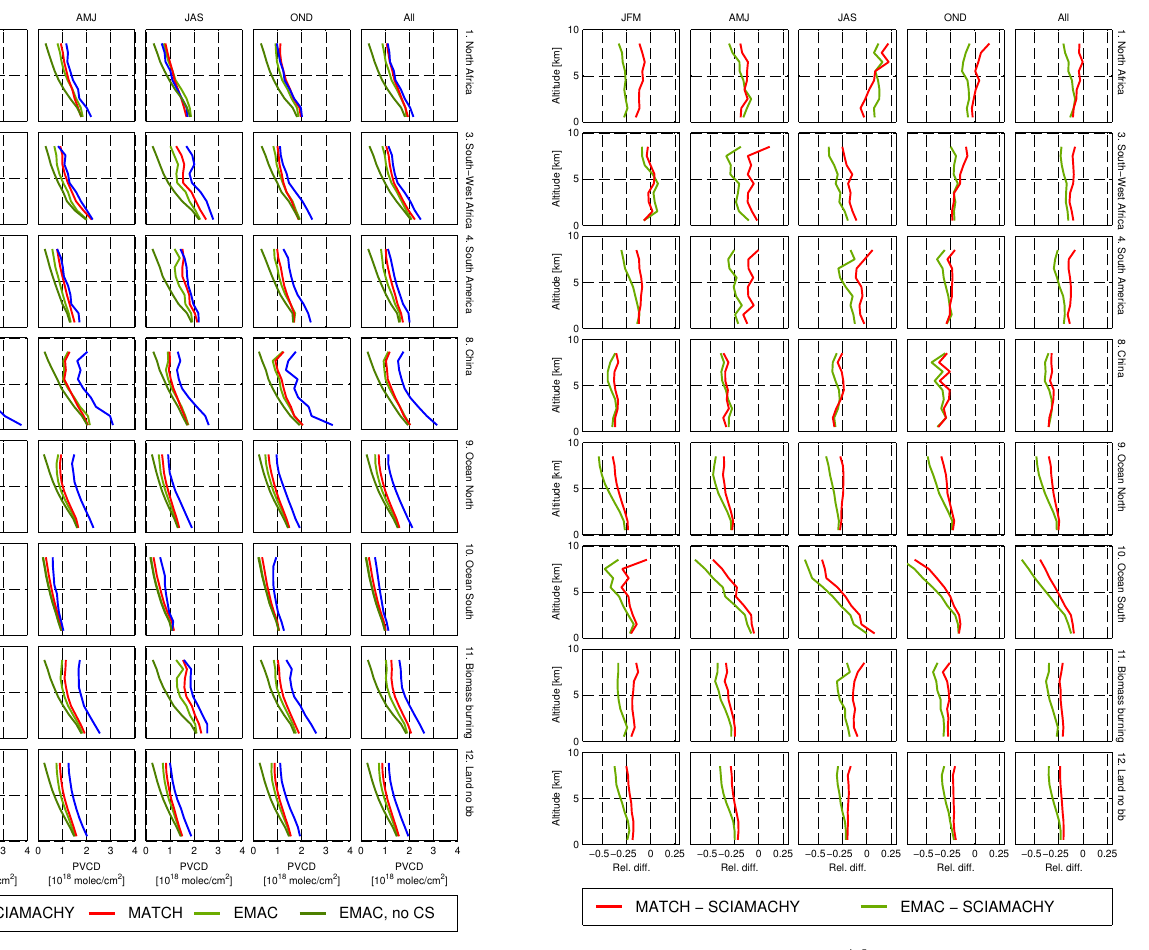
Fig. 9. Comparison of seasonally and annually averaged profiles of CO PVCDs from SCIAMACHY observations and model sim- ulations for selected regions (see Fig. 8). In addition to results for the selected regions, also average results for biomass burn- ing regions (second row from bottom) and for observations over continents far away from strong emission sources (total CO VCD <2.8 · 10 18 moleccm − 2 ) (bottom row) are shown. The dark green lines indicate EMAC results without cloud slicing (see text).